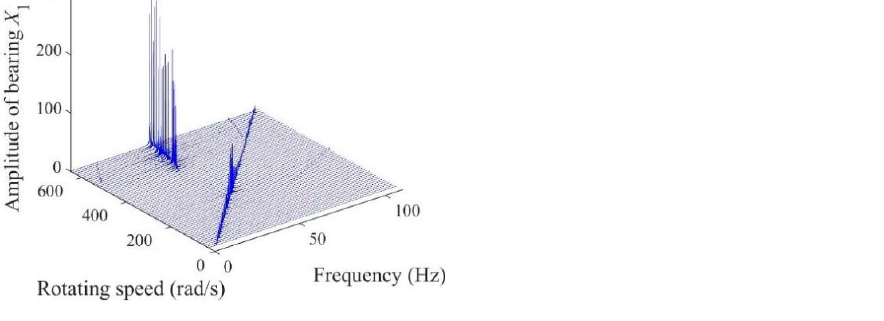
Figure 14. Frequency waterfall chart of the rotating disk along a vertical direction at oil pressure of 0.75 MPa.